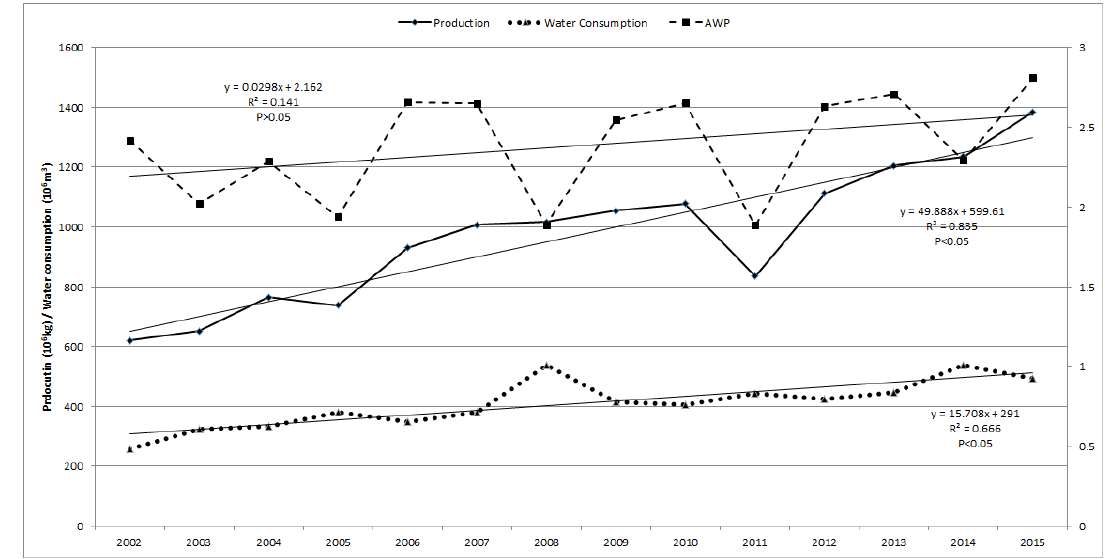
Figure 2. Time-series change of agricultural water productivity (AWP), production and water consumption in Turpan, 2002–2015.